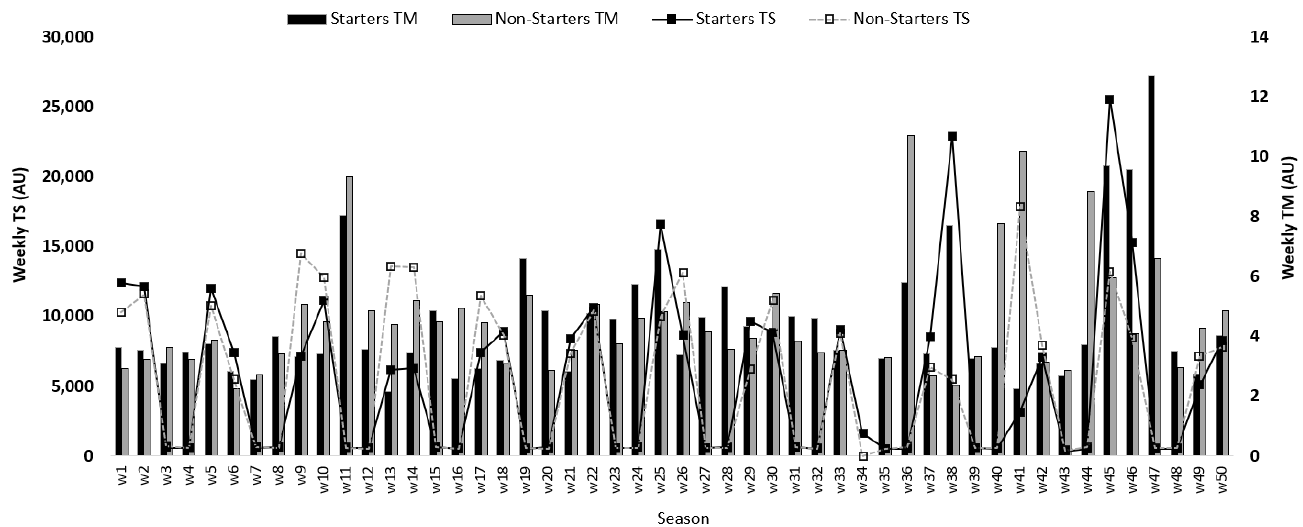
Figure 1. Descriptive statistics of microcycle average for training monotony (TM) and training strain (TS) between starters and non-starters.